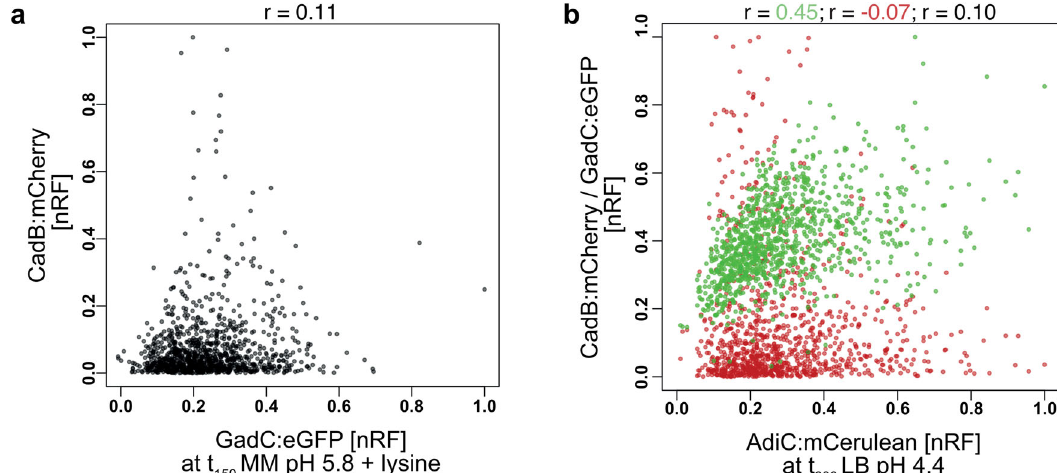
Fig. 3 Simultaneous activation of the AR systems in single E. coli . a Normalized fl uorescence intensity (nRF) presented in a correlation plot of CadC:eGFP versus CadB:mCherry of the strain E. coli gadC:eGFP - adiC.mCerulean-cadB:mCherry in MM at pH 5.8 supplemented with lysine at t 150 . Pearson ’ s correlation coef fi cient ( r ) is shown on top of the graph: r = 0.11 for GadC:eGFP and CadB:mCherry with a p -value of 3.28e − 4 . b nRF presented in a correlation plot of AdiC:mCerulean versus GadC:eGFP (green dots) and versus CadB:mCherry (red dots) of E. coli gadC:eGFP - adiC.mCerulean-cadB:mCherry in LB medium at pH 4.4 at t 300 . Pearson ’ s correlation coef fi cient is shown on top of the graph: r = 0.45 for GadC:eGFP and AdiC:mCerulean (green) with a p-value of 4.4 − 56 ; r = − 0.07 for AdiC:mCerulean and CadB:mCherry (red) with a p -value of <0.05; r = 0.10 fo r GadC:eGFP and CadB:mCherry (black) with a p -value of <0.05. Pearson ’ s correlation coef fi cient was calculated using GraphPad Prism 9.1.0. Correlation plots were created using R 4.0.3. LB lysogeny broth, MM minimal medium, RF relative fl uorescence intensity, nRF normalized RF values, noise standard deviation/mean of log-transformed